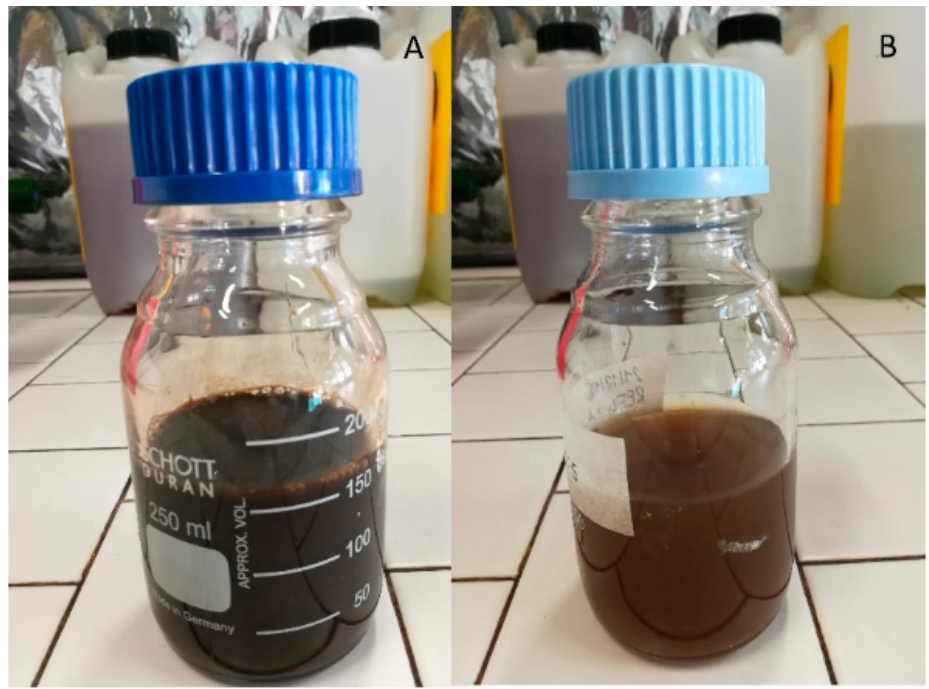
Figure 1. Liquid fraction of digestate from anaerobic digestion of the organic fraction of municipal solid waste (OFMSW): ( A ) as such; ( B ) diluted 1:5.